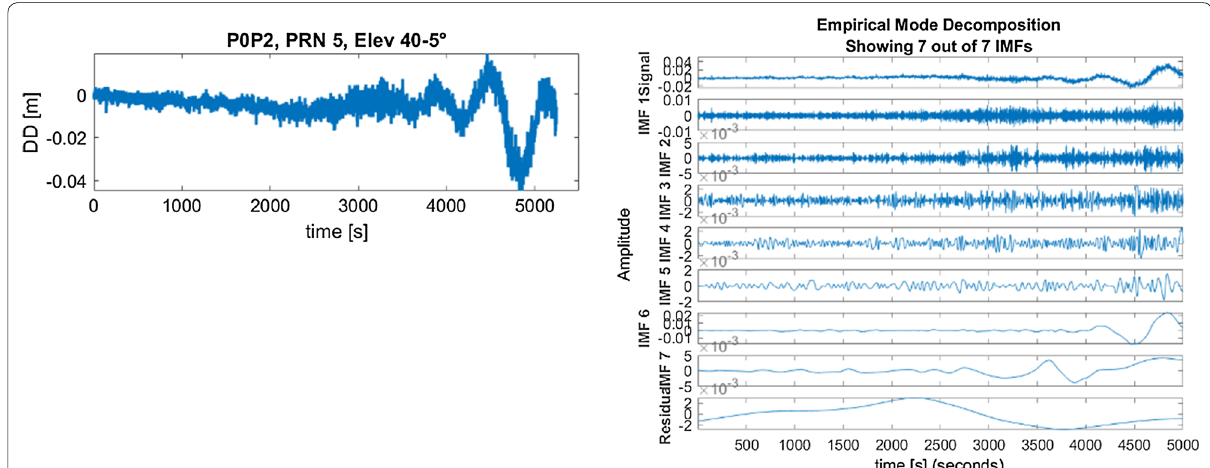
Fig. 8 Left: DD residuals in [m] for PRN5, baseline P0P2. Right: the corresponding EMD decomposition using seven modes, pchip and a threshold of 1e − 6